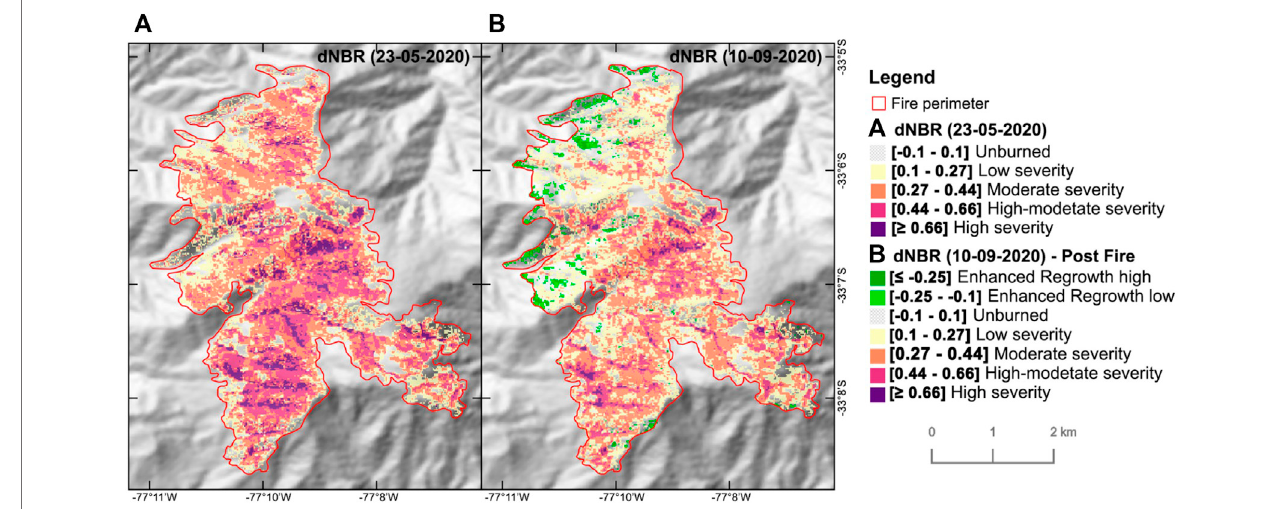
FIGURE 5 | Difference Normalized Burn Ratio (dNBR). (A) dNBR between pre- fi re image (03-05-2020) and post- fi re image(23-05-2020). (B) dNBR between pre- fi re image (03-05-2020) and post- fi re image (10-09-2020).